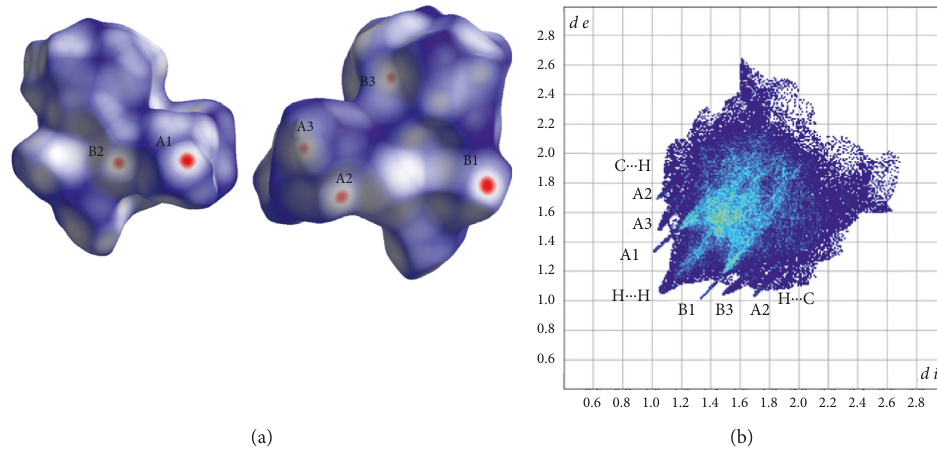
Figure 10: (a) Different views of the d and acceptor contact points of C 8 -H 8 A